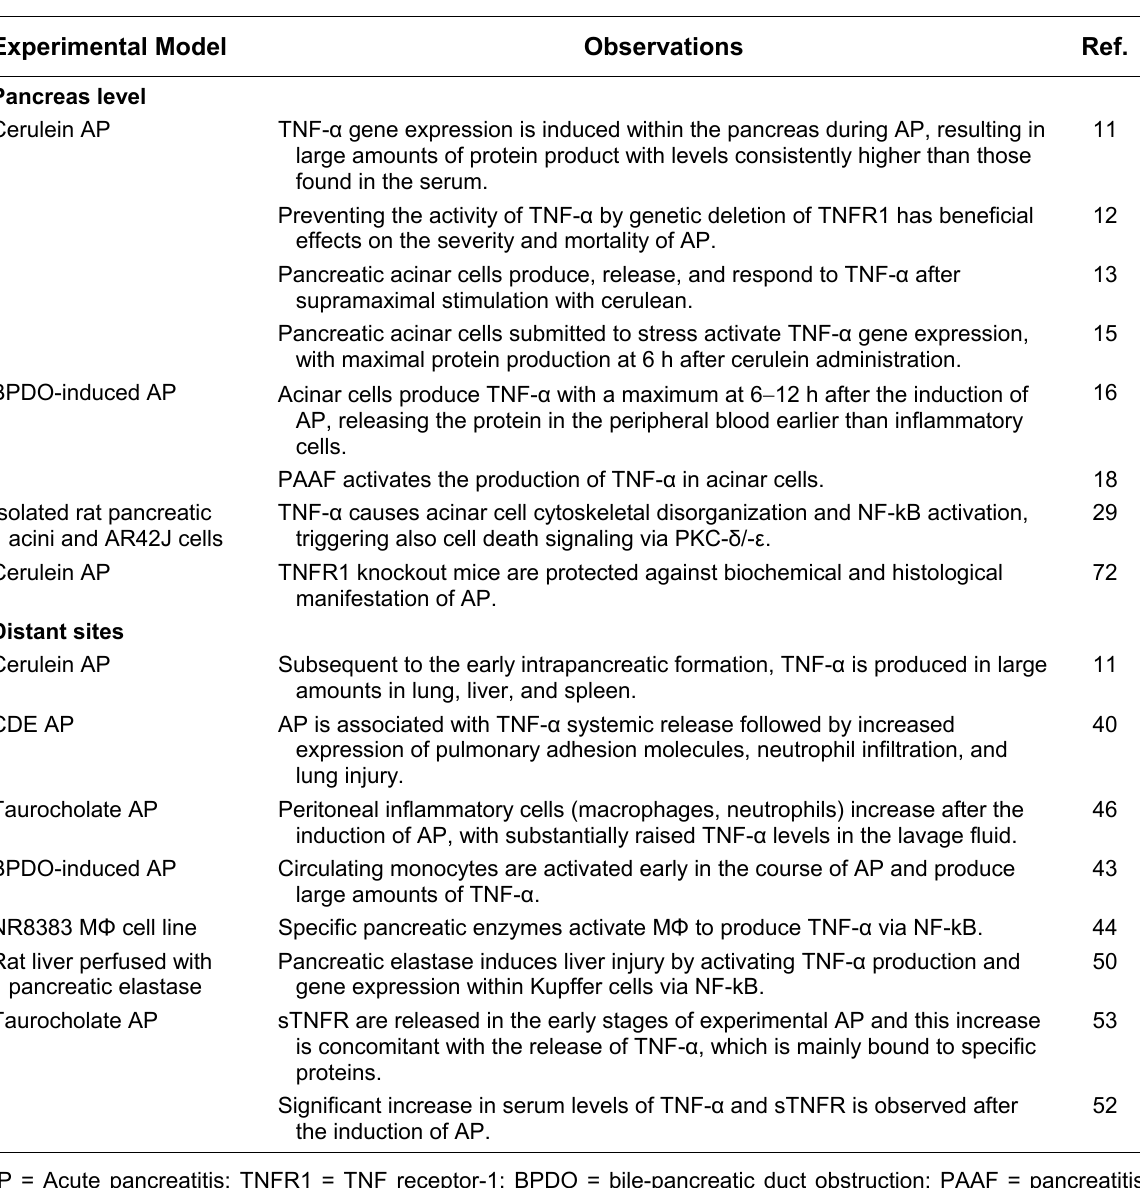
Direct Evidence for a Central Role of TNF- α in the Pathogenesis of Experimental Acute Pancreatitis Experimental